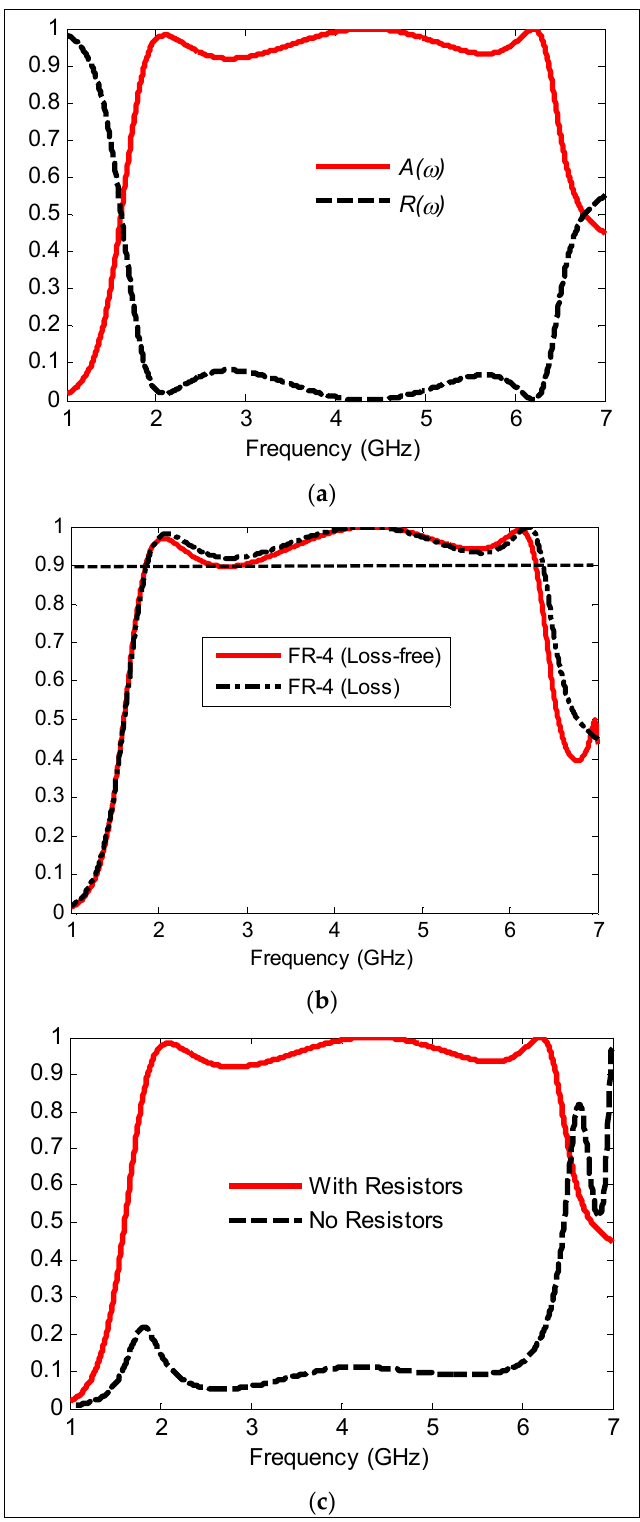
Figure 3. Simulated absorption coefficients: ( a ) simulated absorption and reflection under normal incidence, ( b ) absorption under two different loss conditions, and ( c ) the absorption of the MS absorber with and without resistor loads.